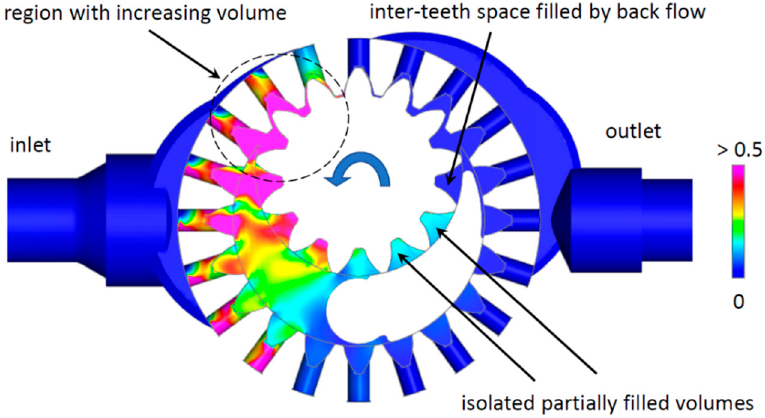
Figure 14. Total gas volume fraction at 3500 rpm (0 only liquid phase, 1 only gas